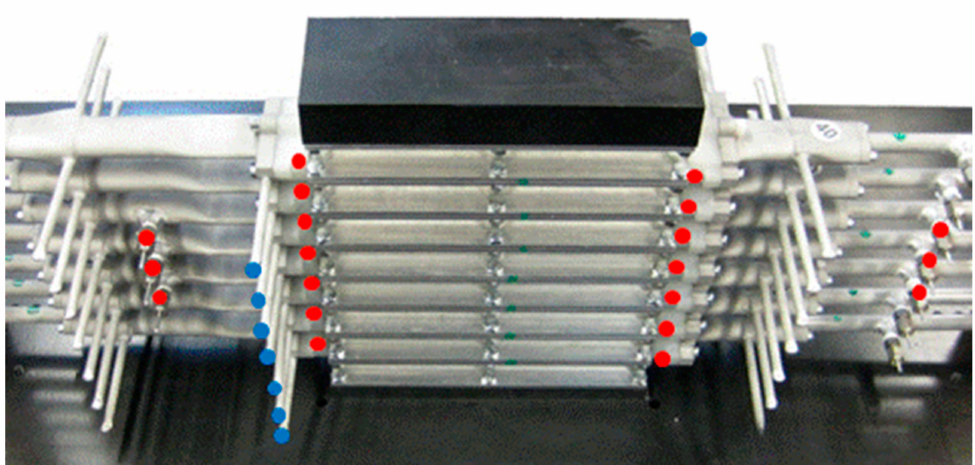
Figure 3. Test section and supply pipes without insulation (flow direction from left to right); access points for temperature and pressure sensors are marked in red and blue respectively. Reproduced with permission from [16], published by Elsevier 2021.